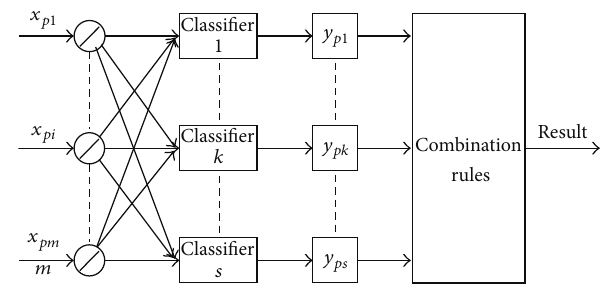
Figure 3: An example of combining classifier.